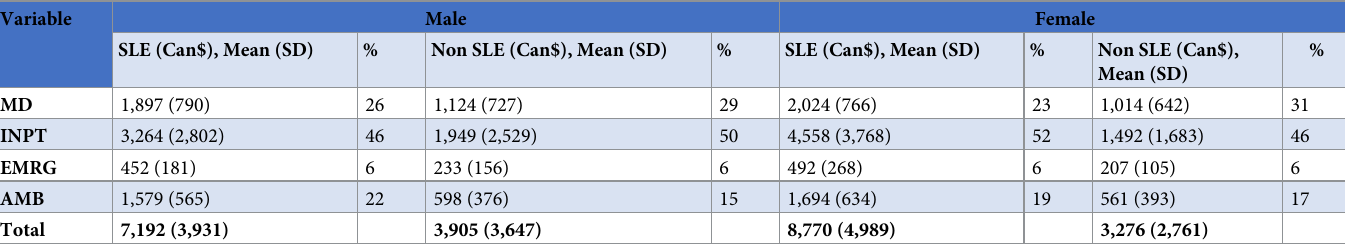
Table 3. Costs of SLE and non SLE per case by sex.